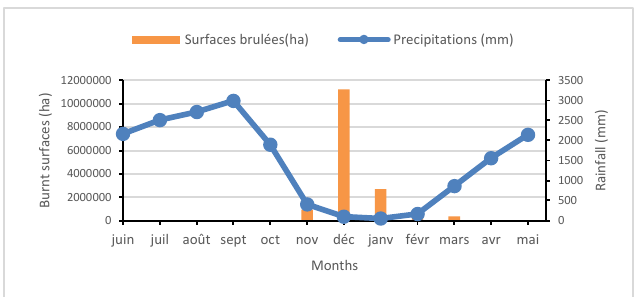
Figure 13: Interrelation between rainfall and burnt surfaces